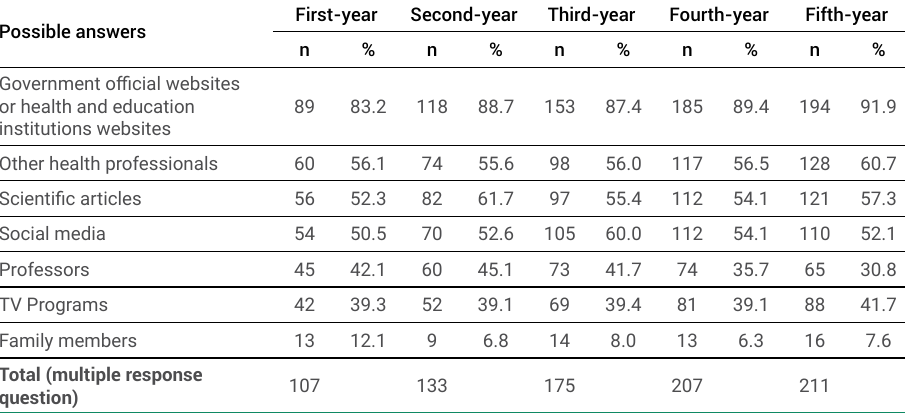
Table 4. Dental students’ source of information about COVID-19 by year of